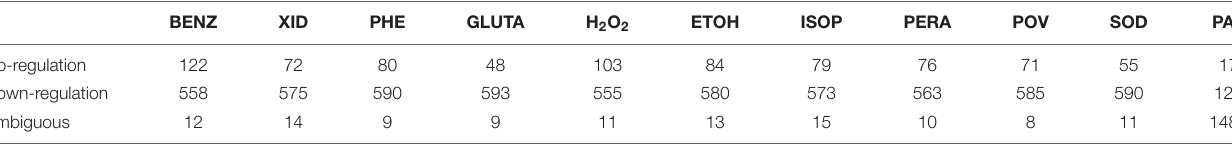
TABLE 4 | Differentially regulated flux predictions for the given condition. BENZ XID PHE